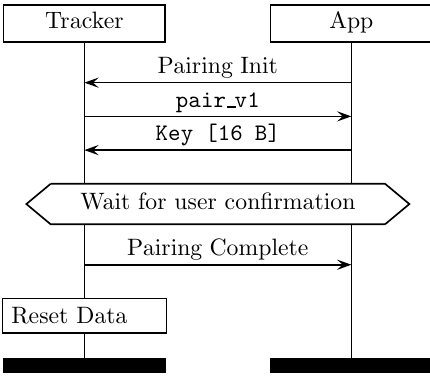
Figure 2: Xiaomi Pairing v1. The app generates and sends to the tracker a 16-byte pairing key ( Key ) in the clear. The tracker shows a pairing confirmation message to the user. Once the user confirms, the tracker resets its data, and pairing is